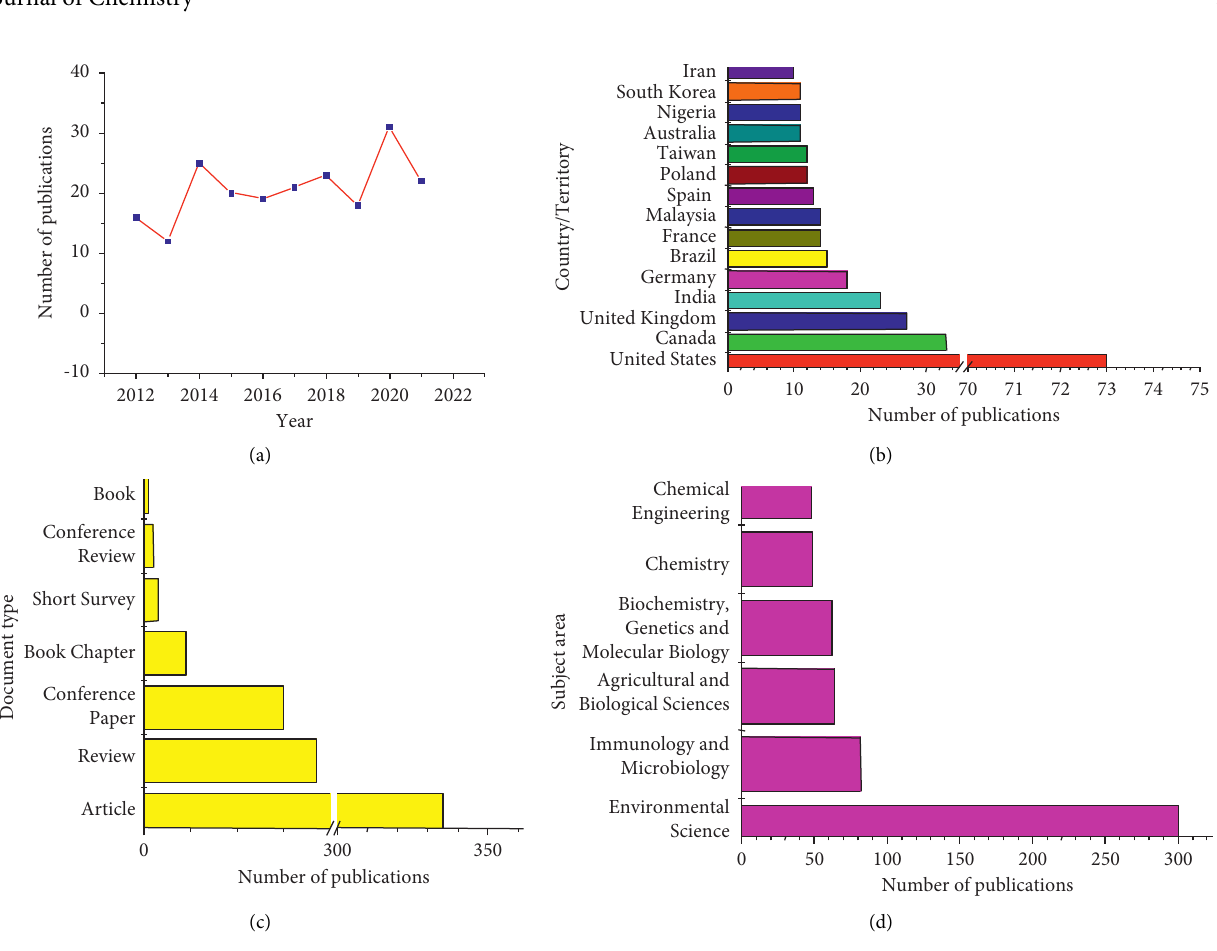
Figure 1: Graphical representation for the scopus database document output for the keywords (TITLE-ABS-KEY ({bioremediation} AND {hydrocarbon} AND {soil} AND {factors}) (Scopus database as on 16 July 2021): (a) documents for year-wise for the period of 2012–2021, (b) documents by major fifteen countries/territories, (c) documents by type, and (d) documents by major six subject